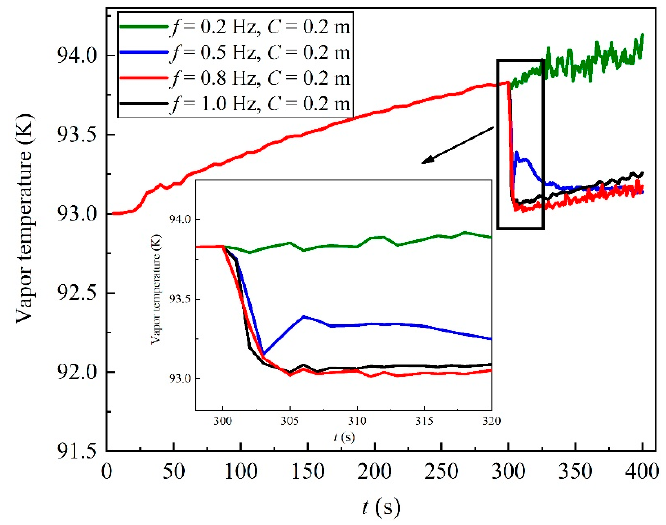
Figure 12. Vapor temperature with different sloshing frequencies.